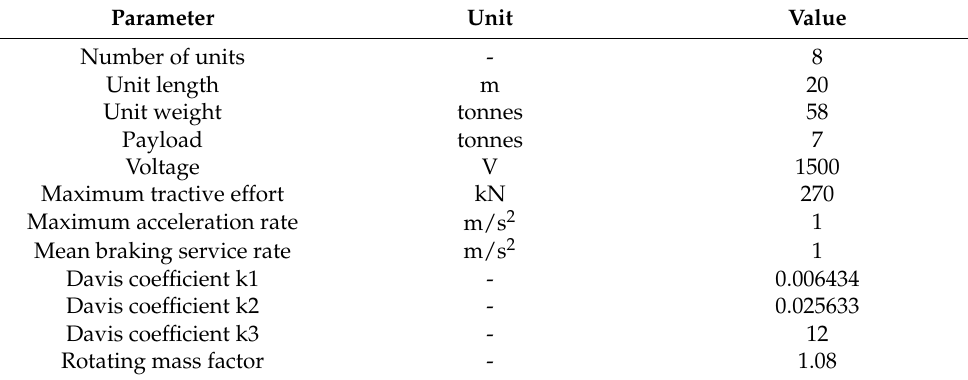
Table 11. Train input parameters.